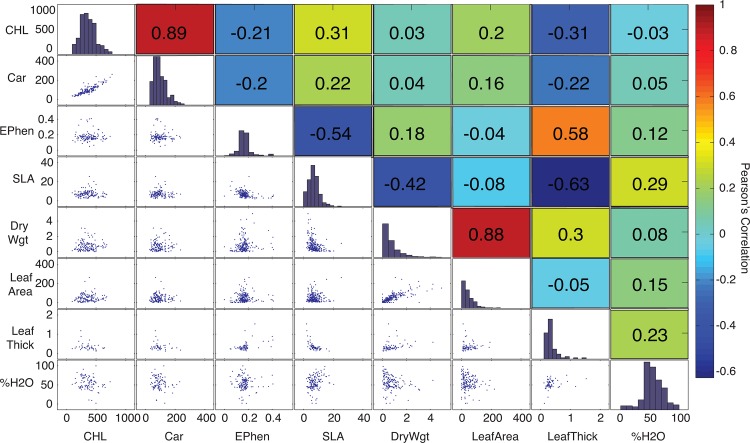
Leaf trait distributions, relationships and correlation (Pearson’s R) across all individuals.CHL = Total Chlorophylls A + B (mol), Car = Carotenoids (mol), EPhen = Polyphenol content, SLA = Specific Leaf Area (m2 kg-1), LeafArea = Leaf surface area (cm2), LeafThick = Leaf thickness (mm),%H2O = Percentage Leaf Water Conent